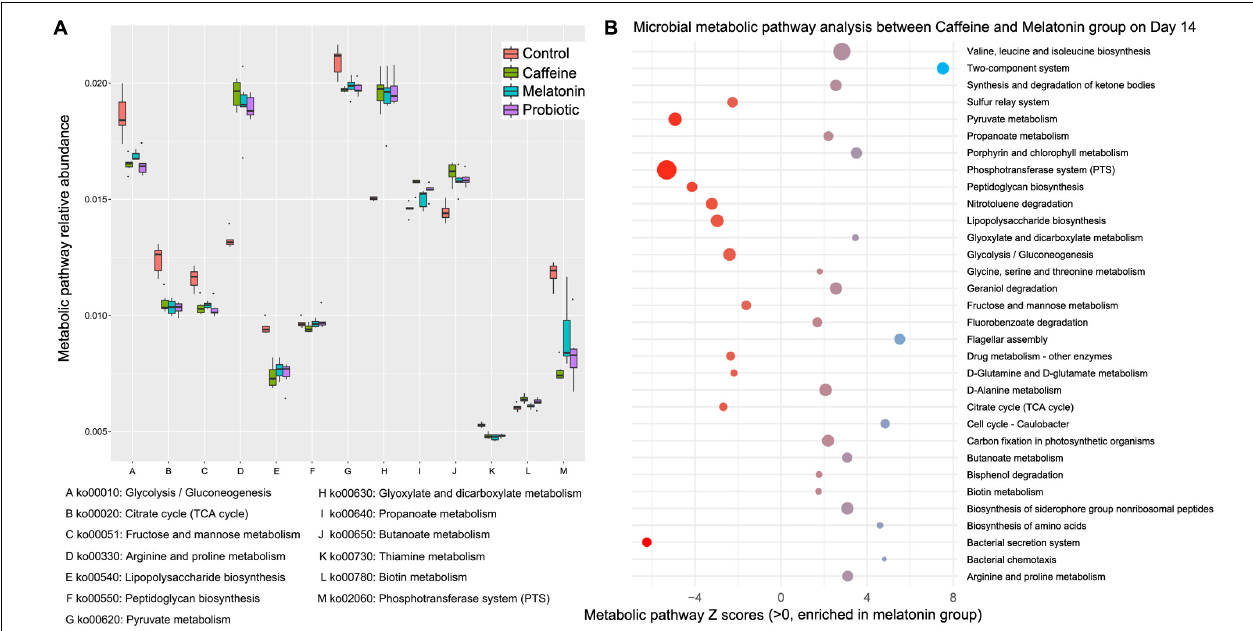
FIGURE 4 | Differential functional features of the zebrafish intestinal microbiota in the caffeine, melatonin, probiotic, and control groups after 14 days of corresponding treatment. Metabolic pathway analysis was performed based on the shotgun metagenomic sequencing data, which were compared with the KEGG database to further explain the microbial metabolic pathways. (A) Metabolic pathway relative abundance. (B) Microbial metabolic pathway analysis between Caffeine and Melatonin group on day 14, Z scores > 1.6 were selected as significant differences.